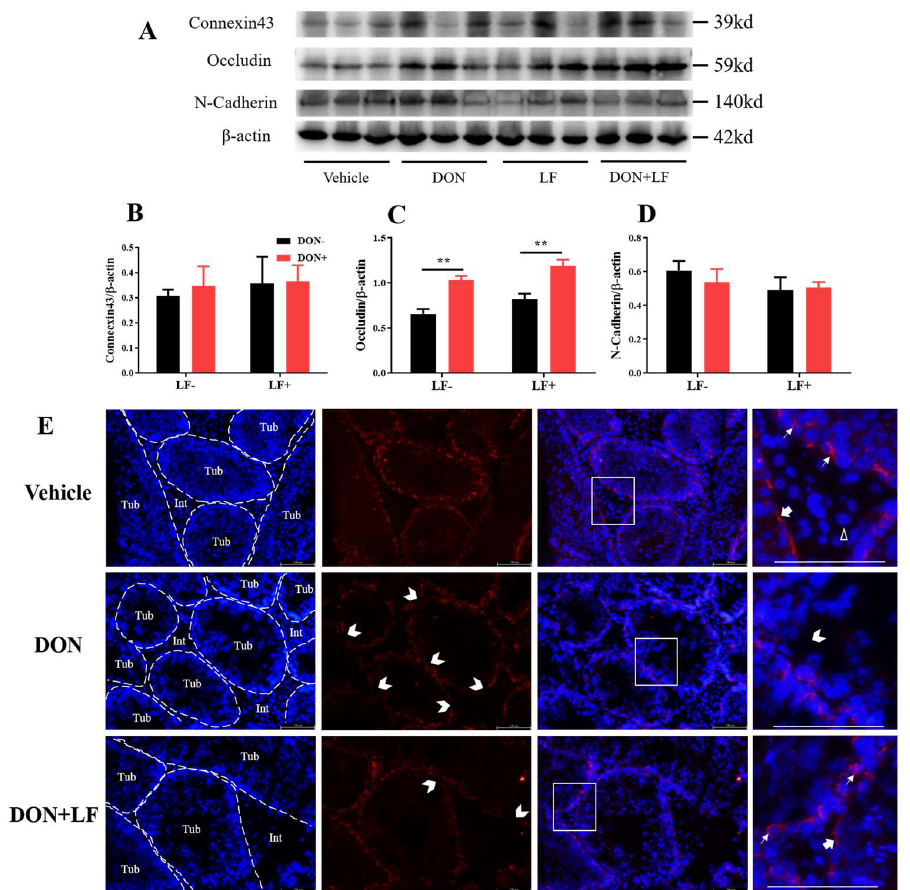
Figure 4. Effects of dietary DON and oral administration of LF on the expressions of BTB junction proteins. ( A – D ) Immunoblotting of connexin43, occludin, and N-cadherin protein expression nor- malized to β-actin levels and quantification of relative protein density. ( E ) Immunofluorescence staining of N-cadherin protein expression. The dashed lines separate the seminiferous tubules (Tub) from the interstitial tissue (Int). The white arrows indicate N-cadherin-positive staining between the spermatids and Sertoli cells. The bold arrows indicate N-cadherin-positive staining at the basement of the spermatogenesis tubules and the white empty arrowhead indicates the N-cadherin-negative Leydig cell. The open arrowheads indicate missing N-cadherin-positive staining sites between Ser- toli cells and spermatids in the tubules. Data were presented as mean ± SEM. For one-way ANOVA, * p < 0.05 and ** p < 0.01.